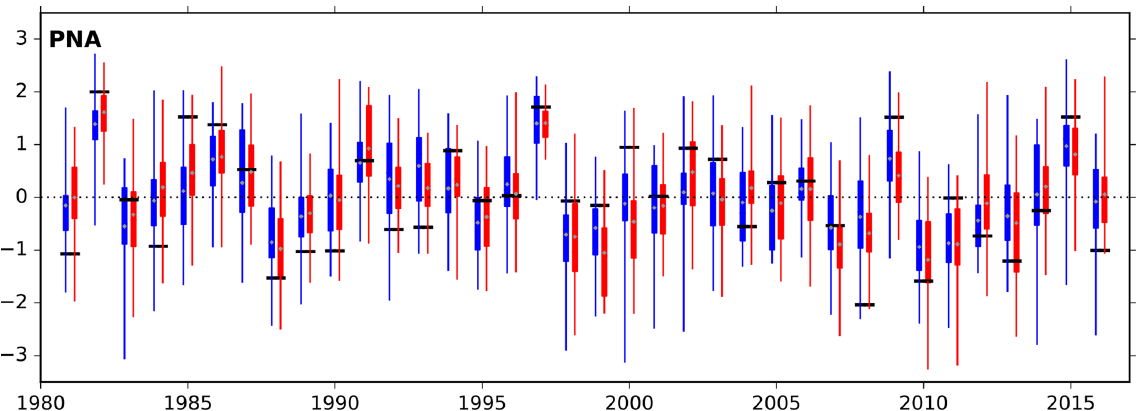
Figure 12. As in Fig. 11, but for a PNA index. Anomaly correlation values for the ensemble mean are 0.69 for both systems. The 95% confidence interval for sampling error over years for SEAS5 is 0.47 to